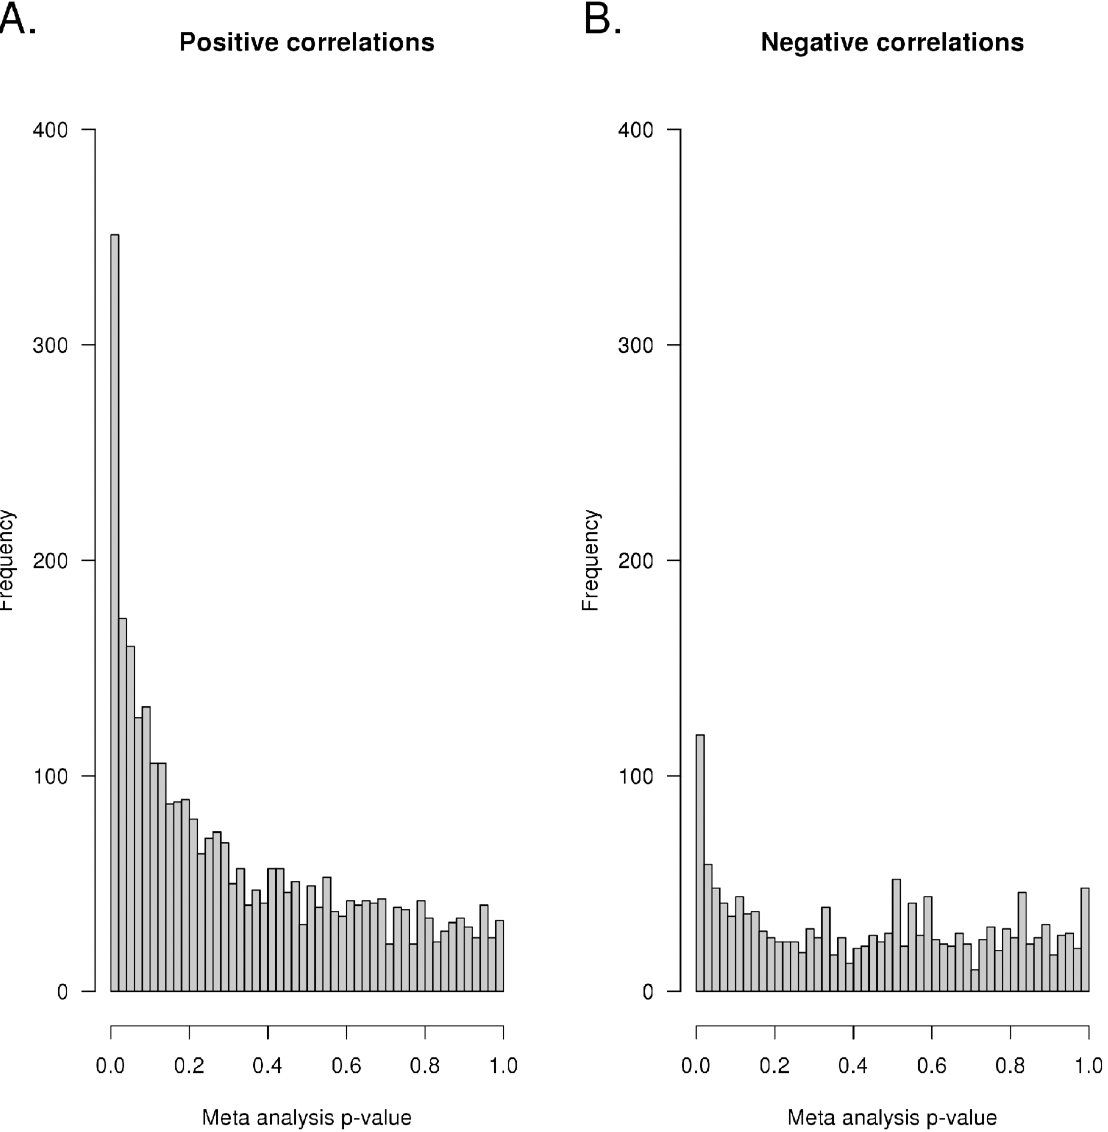
Fig 5. Higher expression of microRNAs forming triplex structures with duplex DNA is more frequently associated with increased gene expression. MicroRNA and mRNA expression were measured in leukemia cells (ALL) obtained at the time of diagnosis from two cohorts of patients (St. Jude Protocols Total 15 and Total 16). Genome-wide linear correlations between microRNA expression and mRNA expression calculated to form grade 1 triplex structures were assessed in each cohort separately and then a meta-analysis was performed. (A) The distributions of Spearman p-values for associations with positive or (B) negative correlations are shown. Over-representation of small p-values for positive associations was significantly enriched as compared to negative